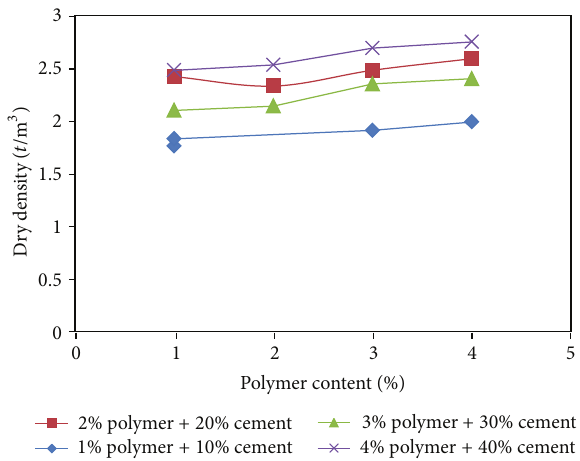
Figure11:Effectofpolymercontentonmaximumdrydensityofsoil in wet conditions for 15 days.